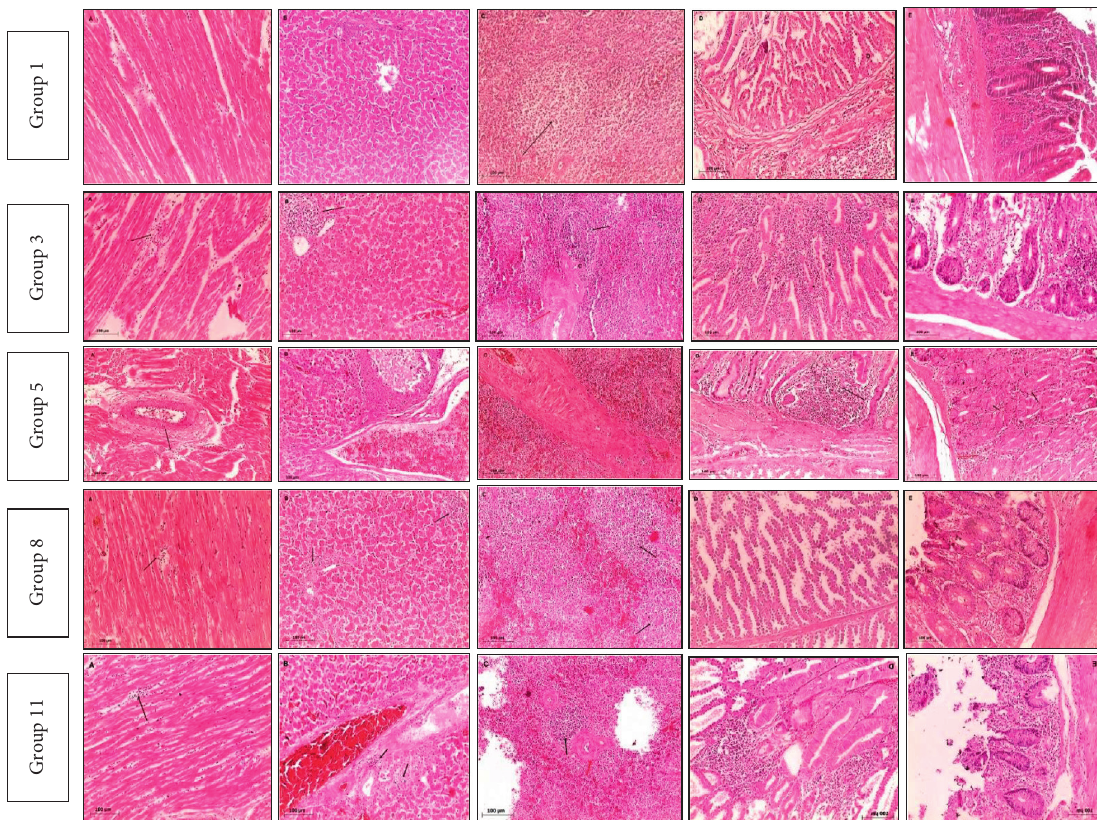
Figure 2: Microscopic picture of infected groups with MDR Salmonella Enteritidis